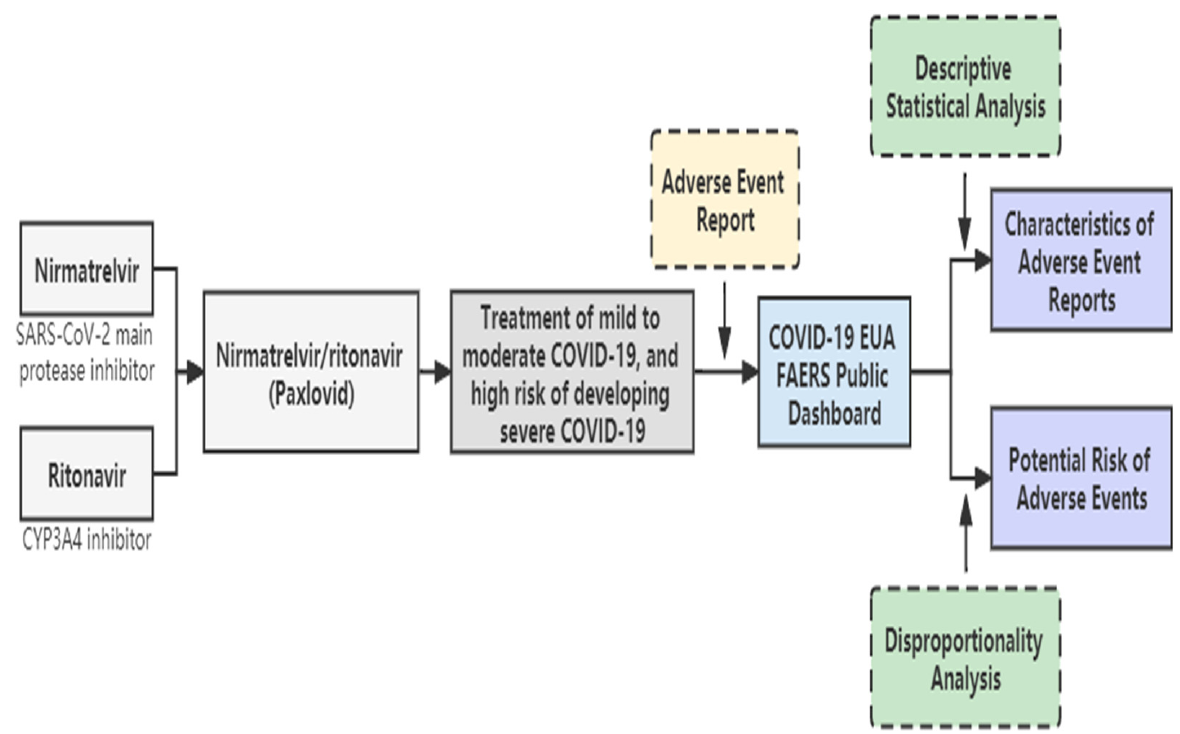
Figure 1. Graphical workflow of this article.